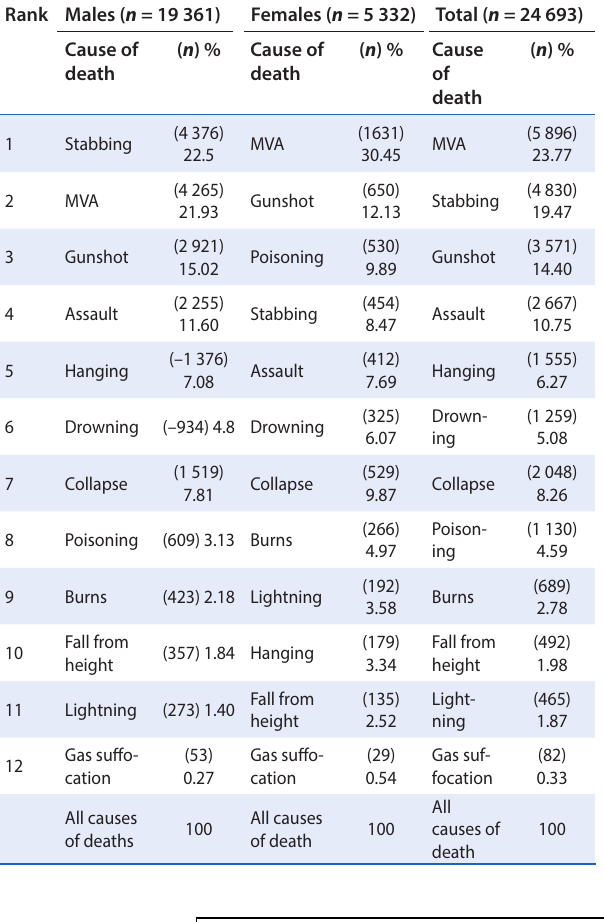
Table 2: Ranking by percentage of cause of death by gender in Umtata area, South Africa 1996–2015 Rank Males ( n = 19